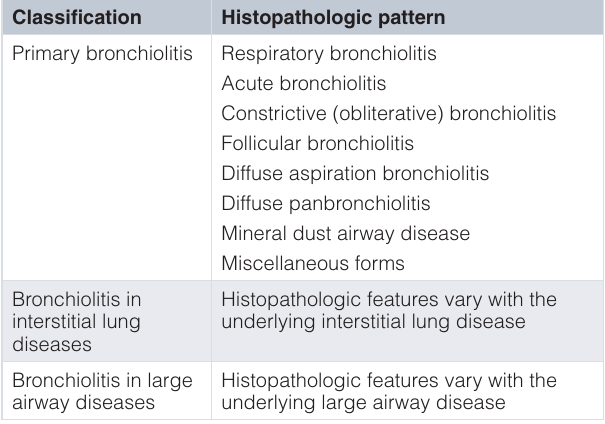
Table 1. Classification of